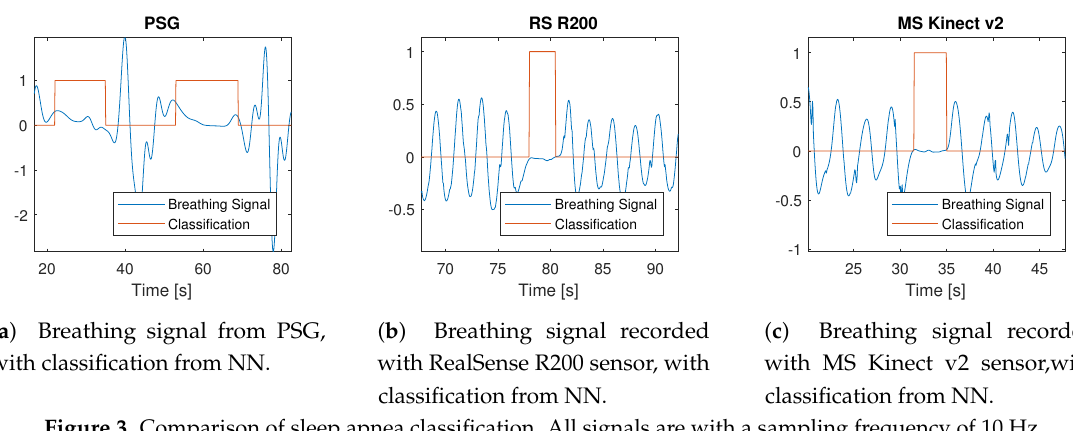
Figure 2. Training data with classification and example of selected central apnea event.